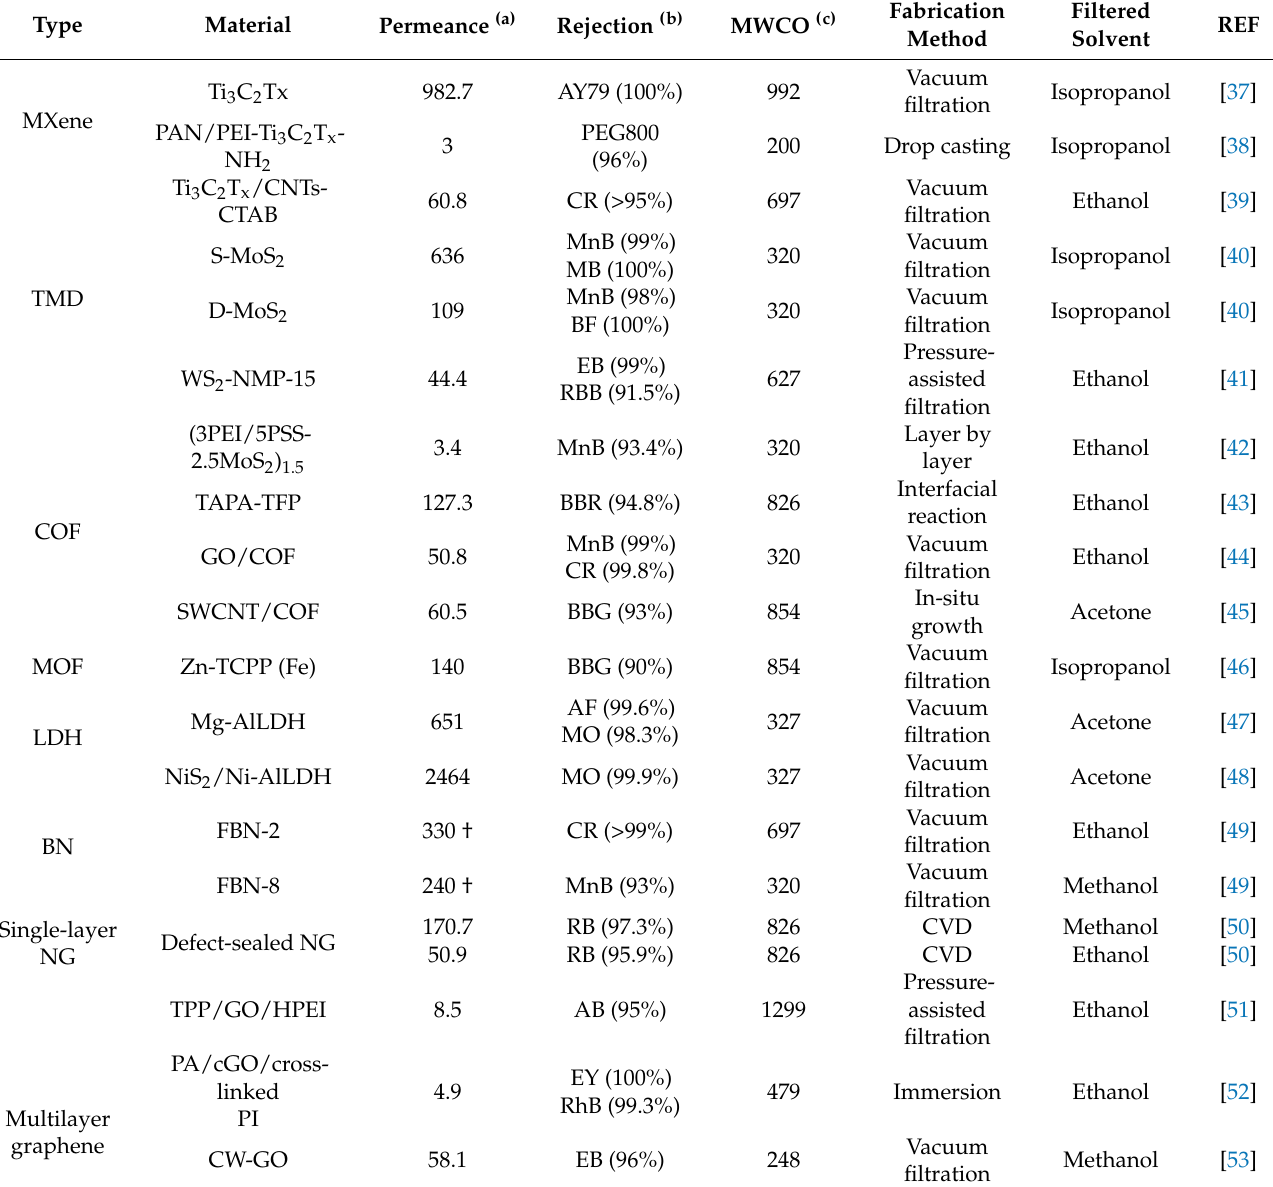
Table 1. Summary of the organic solvent nanofiltration performance of 2D material-based membranes.